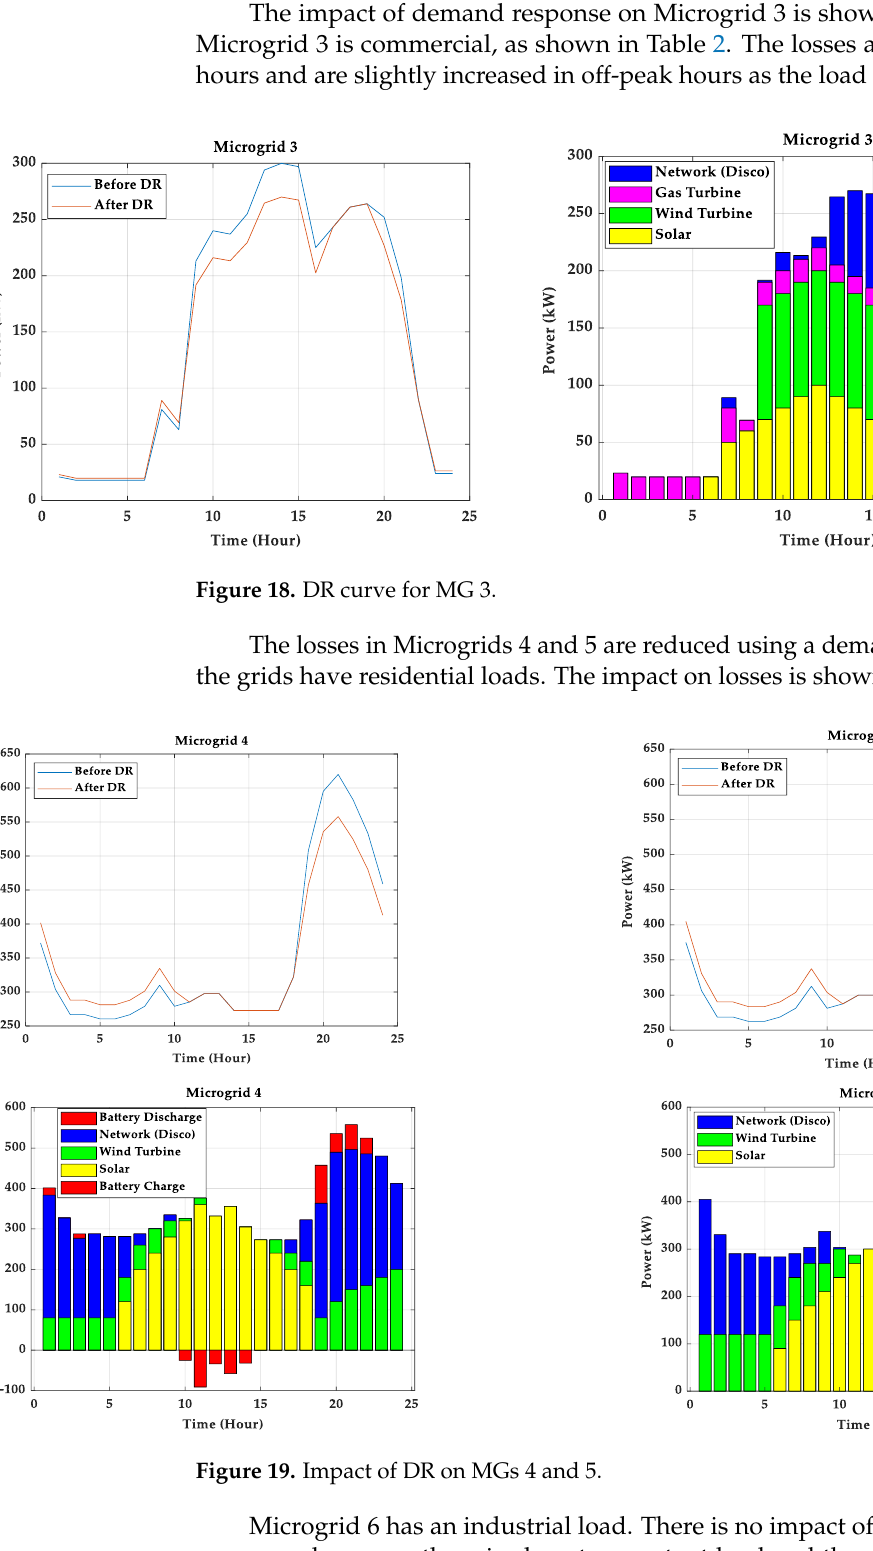
Figure 17. Impact of DR on MG 2.